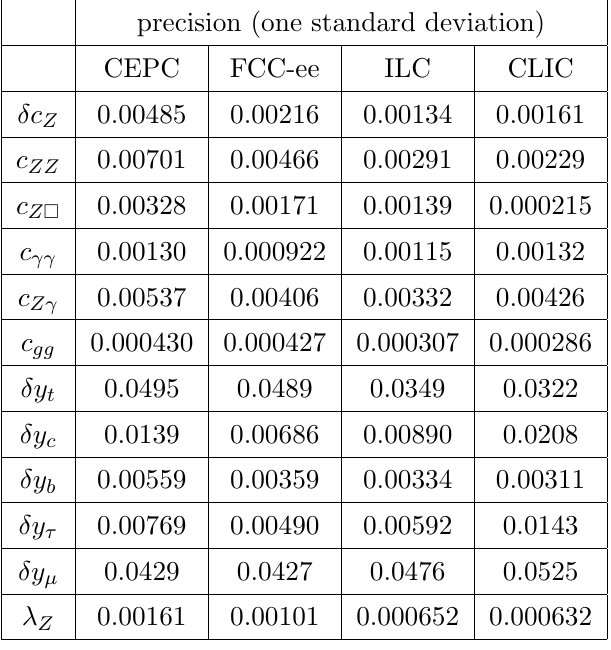
Table 11 . Precision reach (one standard deviation bounds) at each of the four future e + e For each collider, the LHC 3000 fb (cid:0) 1 (including 8 TeV results) + LEP measurements are also combined in the total (cid:31) 2